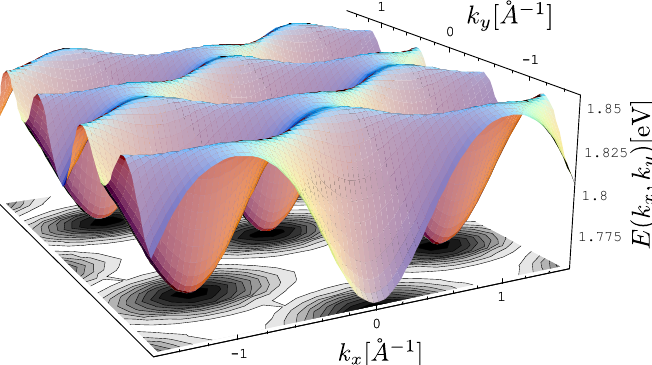
Figure 6. Exciton dispersion in three dimensions. The parameters used for the theoretical fit are as in Figures 2 and